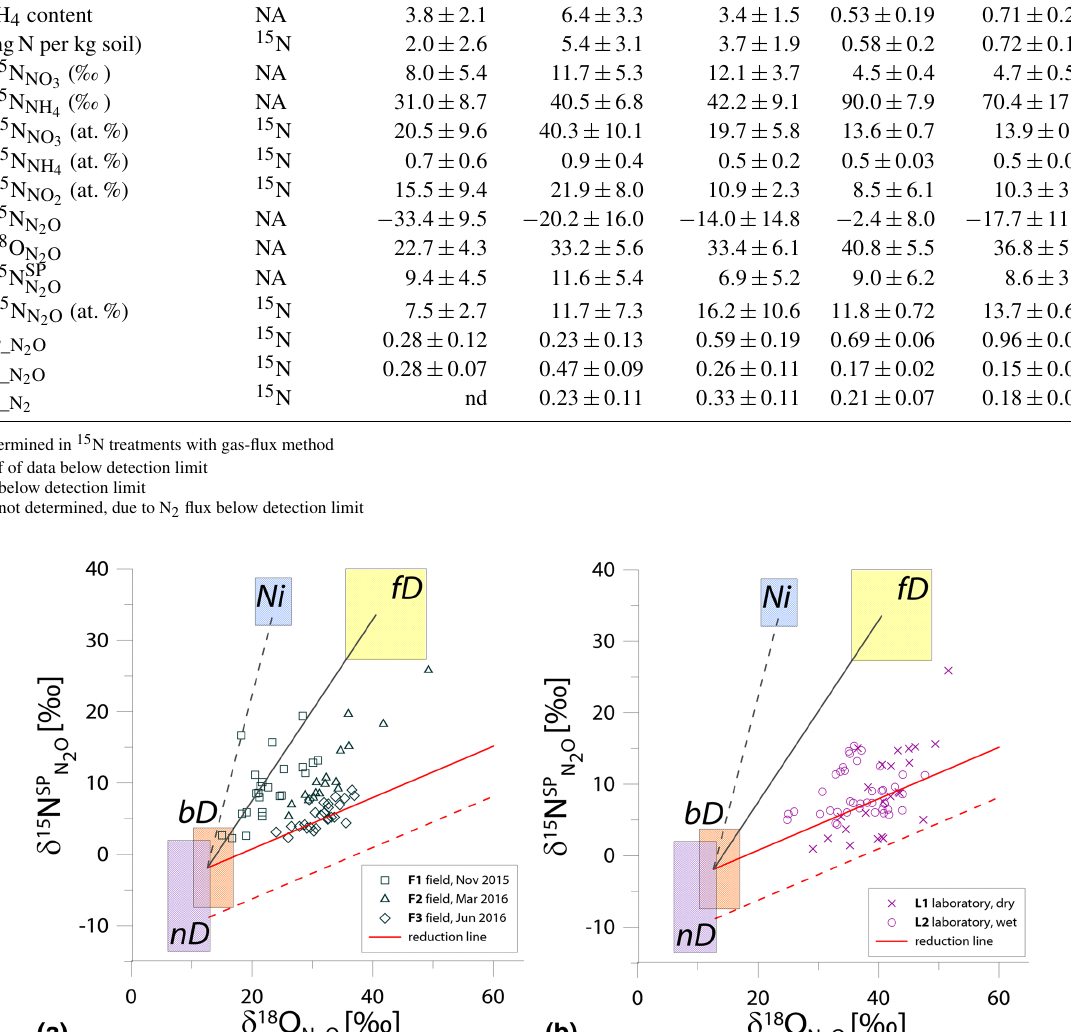
originating from a particular pathway in 2 O